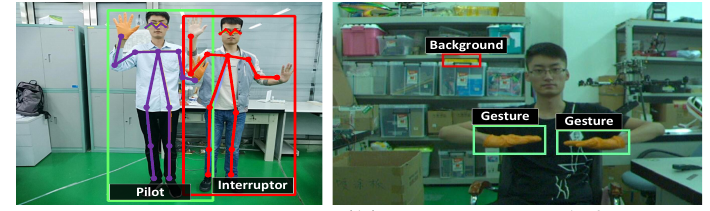
Figure 4. The conventional action or gesture recognition algorithms are difficult to be directly applied for human-robot interaction. ( a ) Action recognition result of Alpha-Pose [28]; ( b ) Gesture recognition result of YOLO V3